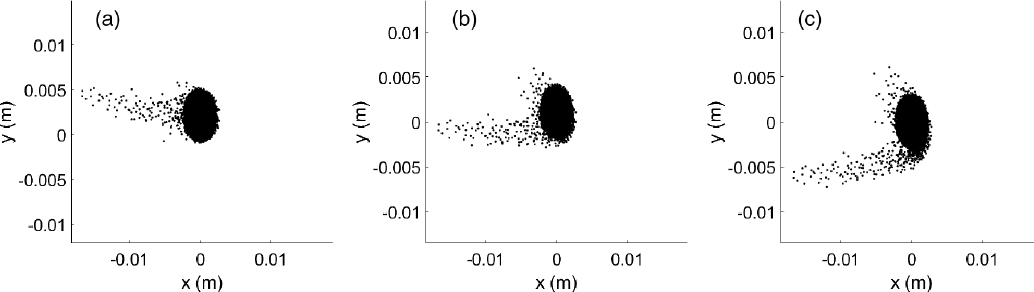
FIG. 22. Simulated beam halo profiles at screen monitor SCM8 location. Horizontal offset of the cavity No. 2 is 2.6 mm. The longitudinal bunch distribution includes 3.3 ps Gaussian core, and the back and forward tails. The steering coils are turned on. The collimators COL1 and COL2 are taken out. (a) Demonstration of those for the collective vertical offset of cavities Nos. 1 – 3 of − 2 mm. (b) For those with the collective vertical offset of 0 mm. (c) For the offset 2